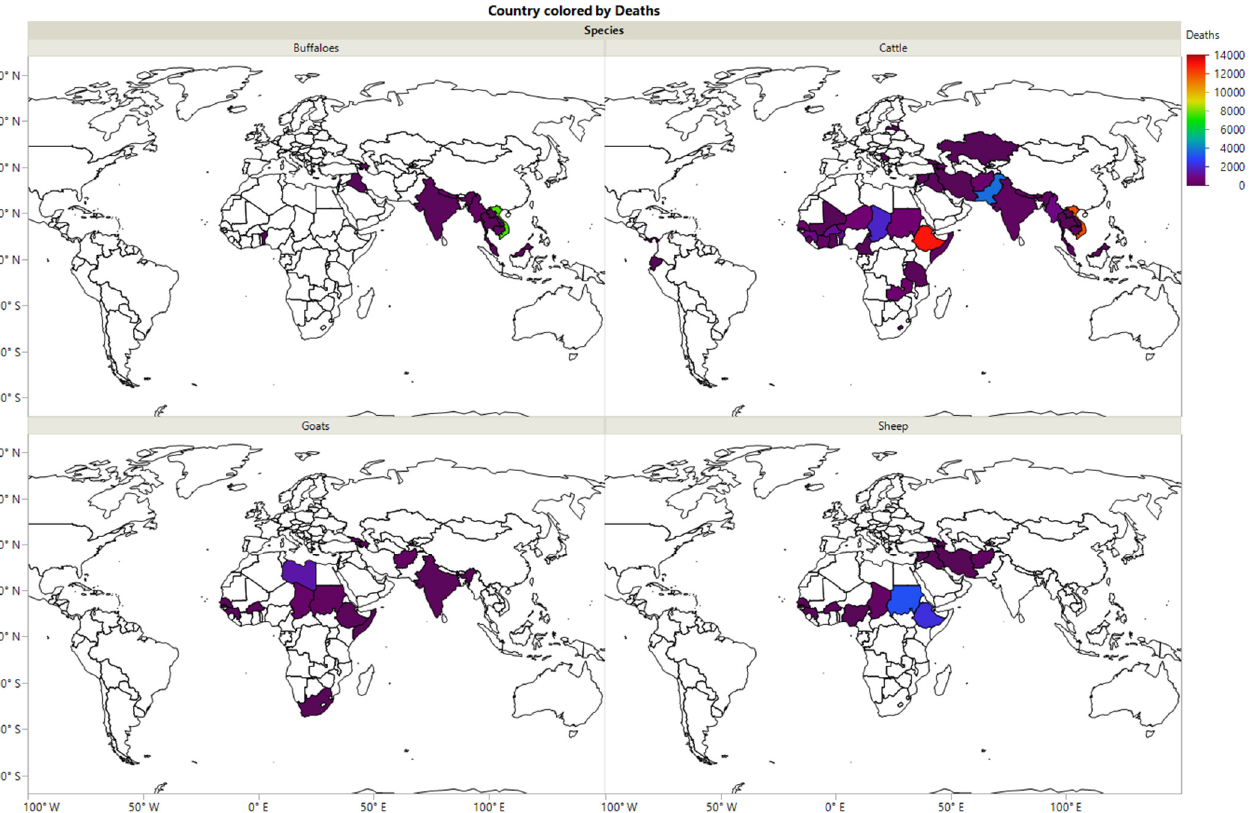
Figure 2. The morbidity of HS among buffaloes, cattle, goats and sheep in different countries during the period 2005–2019.